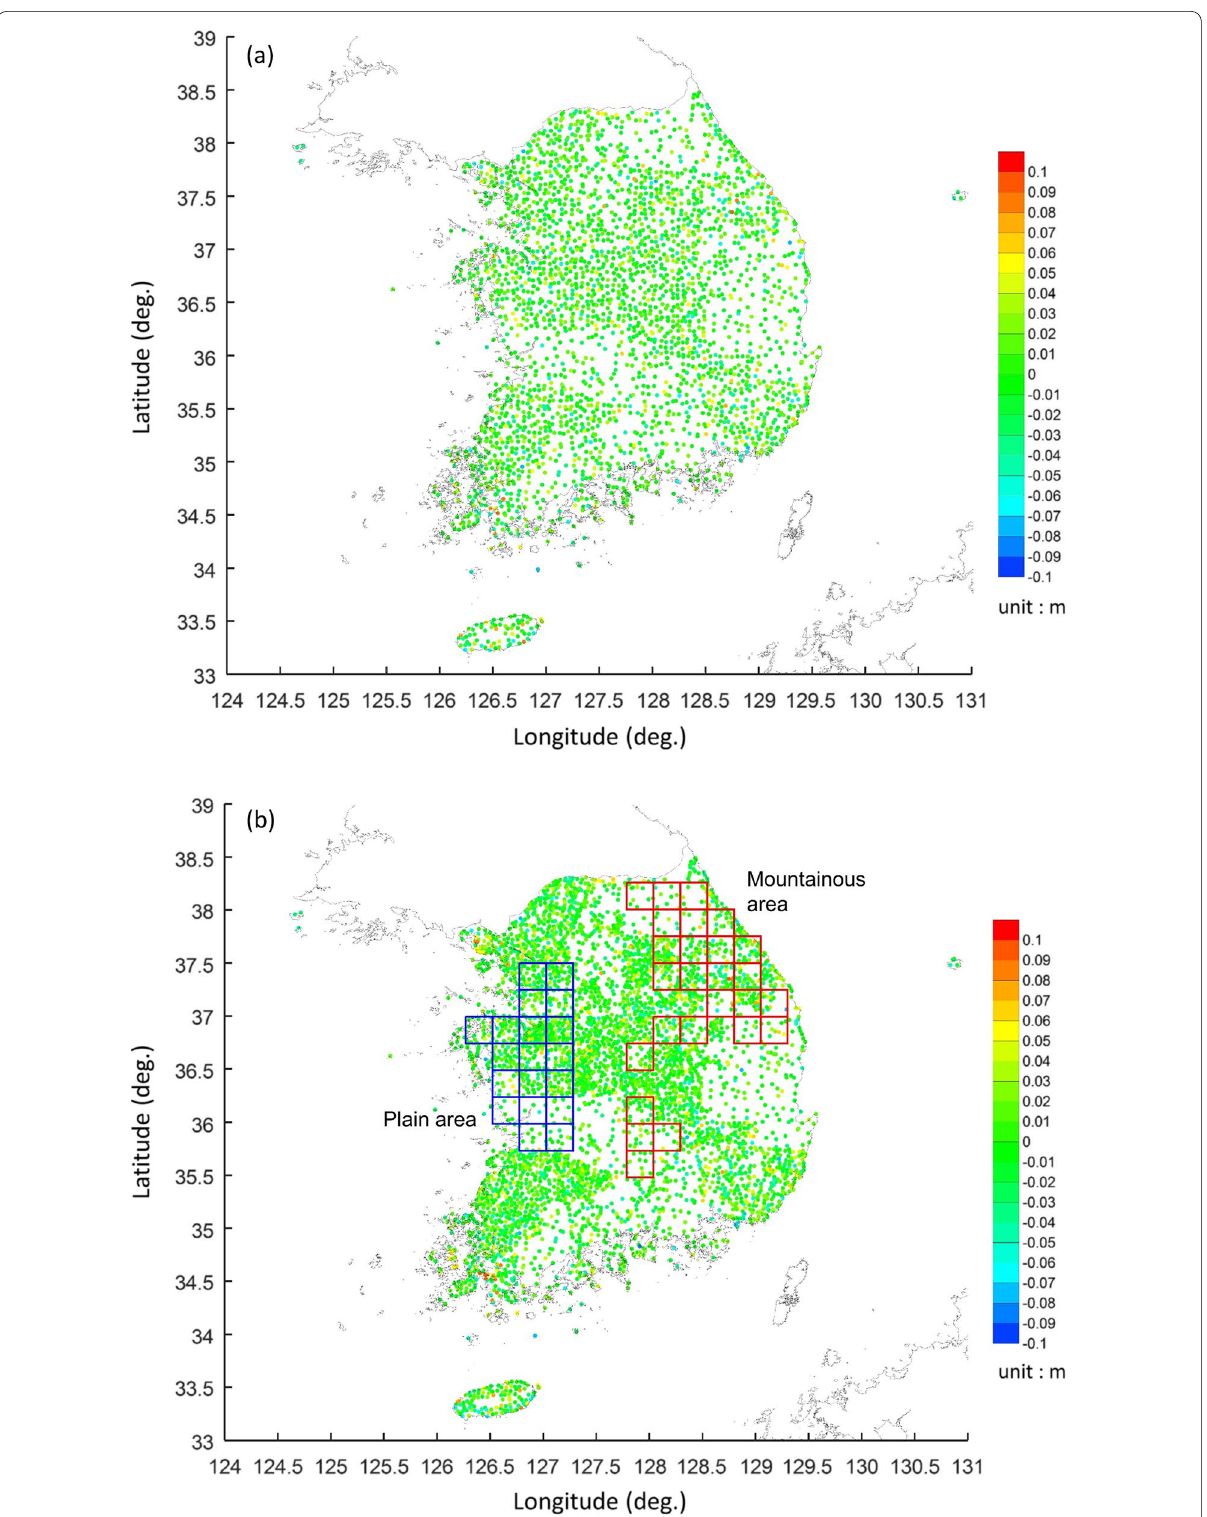
Fig. 8 Geoidal height differences between KNGeoid18 and GNSS/Leveling data: a 2791 fitting points and b a total of 4492 points of GNSS/Leveling data [re-plotted referring to the DOF of KNGeoid18 in Kwon et al. (2018) and regions were newly